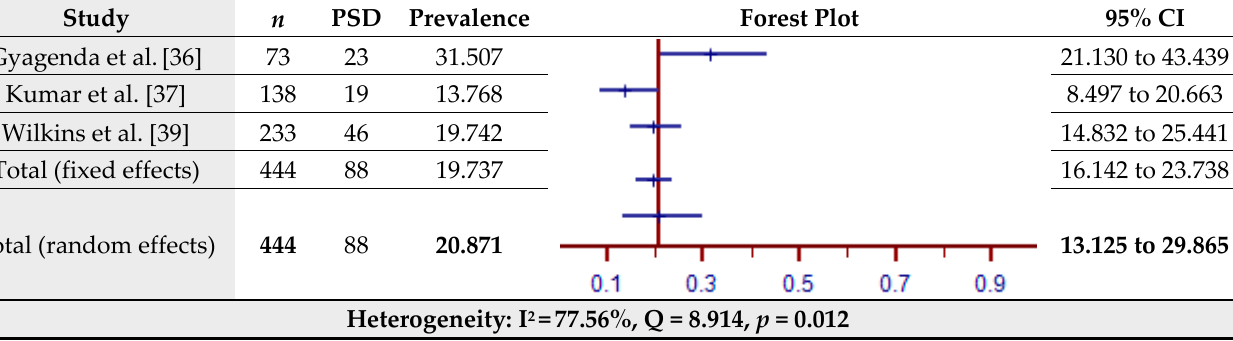
in Figure 8. The pooled prevalence of PSD in the total sample of 237 was 50.24% (95% CI = 32.64–67.81%) based on the random-effects model (I 2 = 86.14%, Q = 14.43, p <